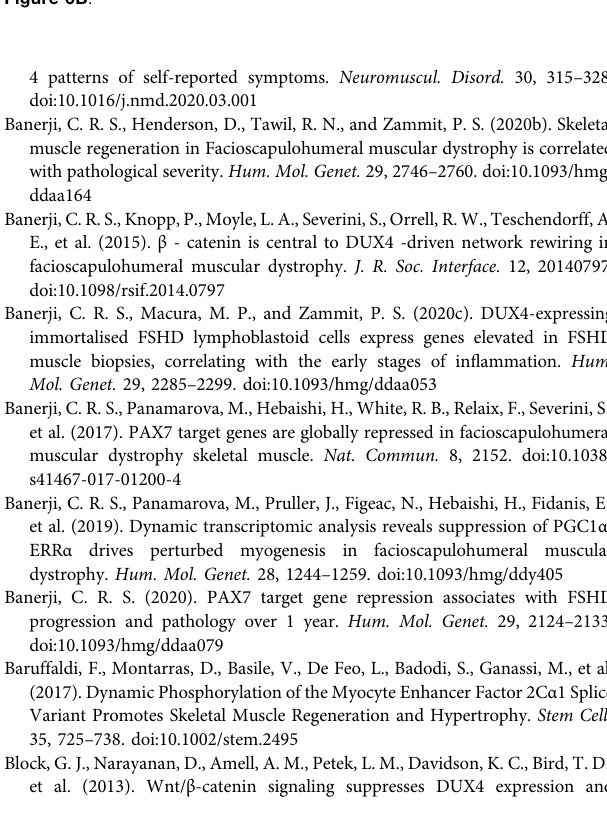
Supplementary Table S2 | List of genes deregulated upon DUX4 or DUX4c overexpression in murine myogenic cells shown in Figure 3 . Supplementary Table S3 | Raw Data as Counts per Million (CPM) and data used by Morpheus to generate the heatmap of the 88 genes used for hierarchical clustering analysis presented in Figure 3 .